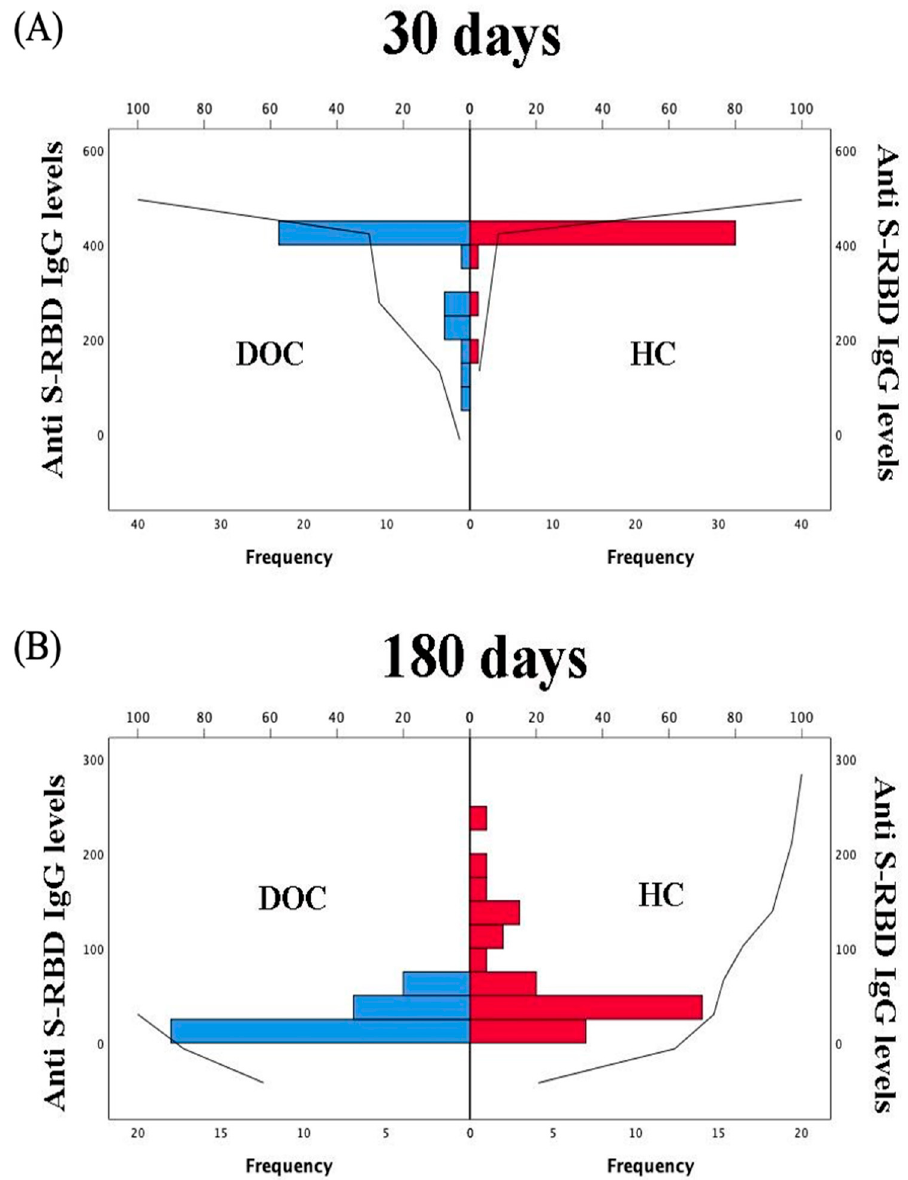
Figure 1. Frequency distribution of anti-S-RBD IgG levels in the two groups after complete vaccination over time at 30 days ( A ) and 180 days ( B ).